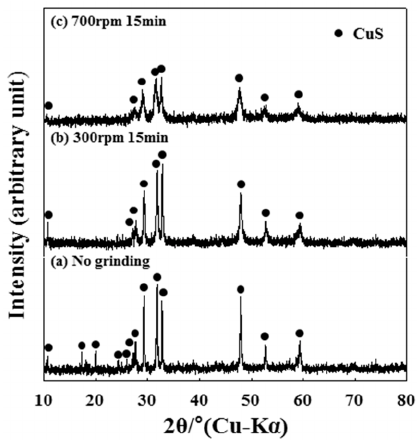
Figure 1. XRD patterns of CuS with various grinding conditions: ( a ) No grinding; ( b ) Ground for 15 min at 300 rpm; and ( c ) Ground for 15 min at 700 rpm.